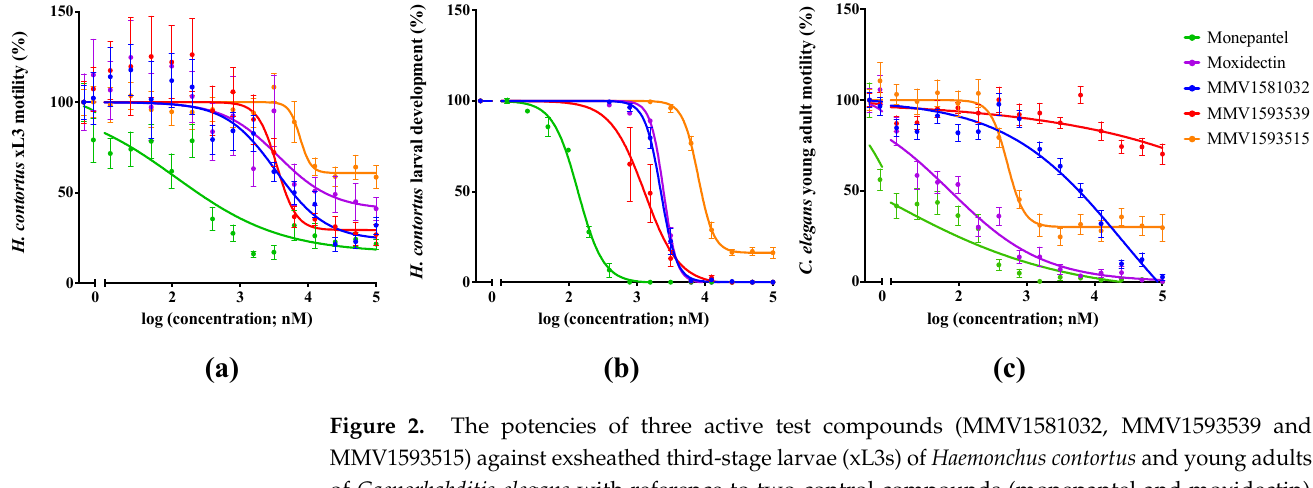
Figure 2. The potencies of three active test compounds (MMV1581032, MMV1593539 and MMV1593515) against exsheathed third-stage larvae (xL3s) of Haemonchus contortus and young adults of Caenorhabditis elegans with reference to two control compounds (monepantel and moxidectin). Dose-response curves show ( a ) the inhibition of H. contortus motility at 90 h, ( b ) the inhibition of H. contortus development at seven days and ( c ) the reduction of C. elegans motility at 40 h. Data points represent three independent experiments conducted in triplicate; the mean ± standard error of the mean (SEM). Table 1. Summary of the potency assessment of hit compounds and positive control compounds (monepantel and moxidectin) on Haemonchus contortus and Caenorhabditis elegans .